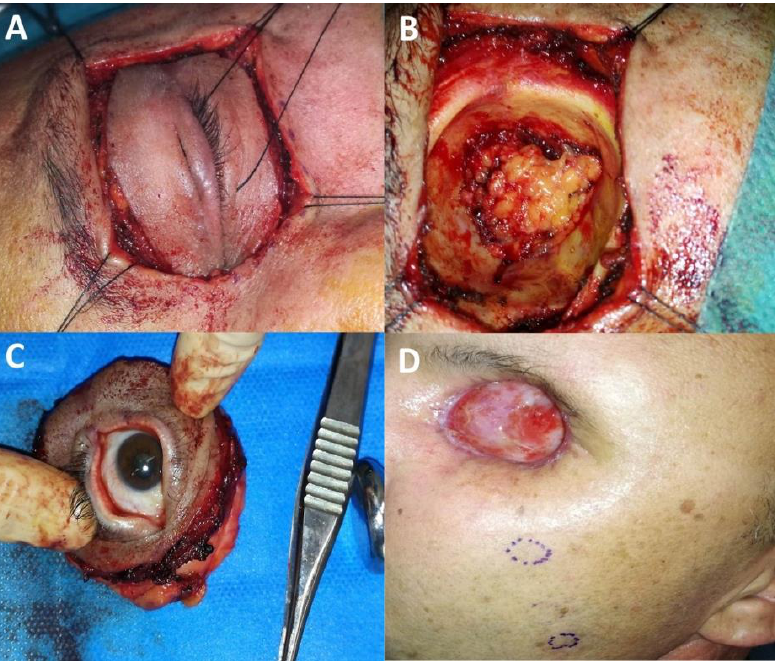
Figure 4. Orbital exenteration (OE) for recurrent tarsal conjunctival melanoma: ( A ) Total OE with incisions performed circumferentially to the orbital rim; ( B,C ) Orbital socket and specimen aspect; ( D ) Lymph node dissemination was palpable 3 months after surgery (purple circles). The orbital socket was reconstructed with an artificial dermis template followed by spontaneous epithelializa- tion. Note the “bowl - shaped” aspect of the orbital socket.